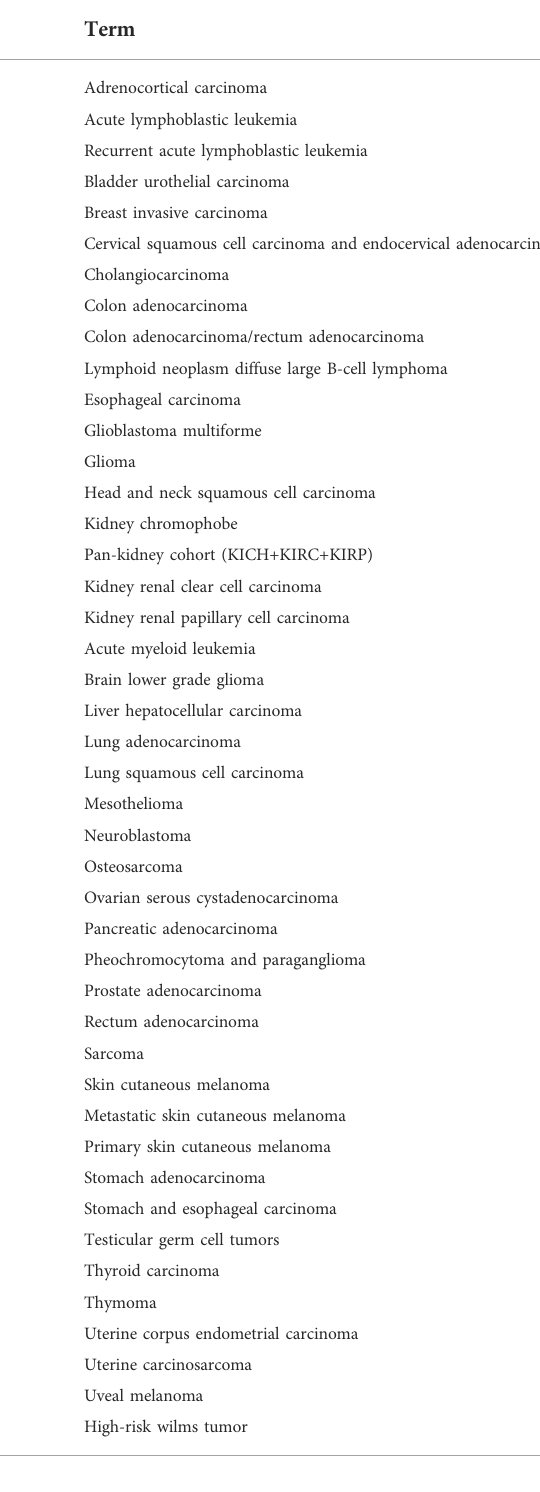
TABLE 1 Abbreviation of each cancer